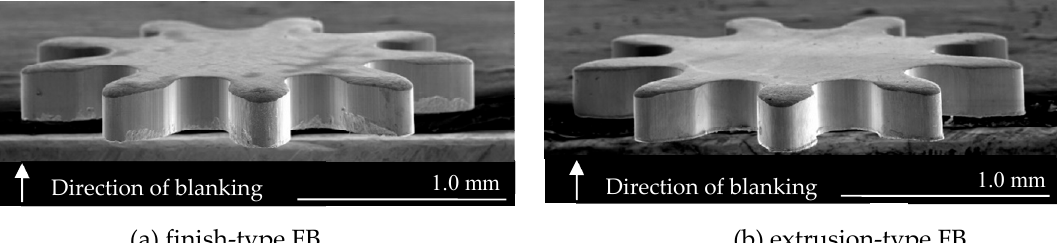
Figure 1. SEM images of the microgear [10]: ( a ) finish-type FB; ( b ) extrusion-type FB.